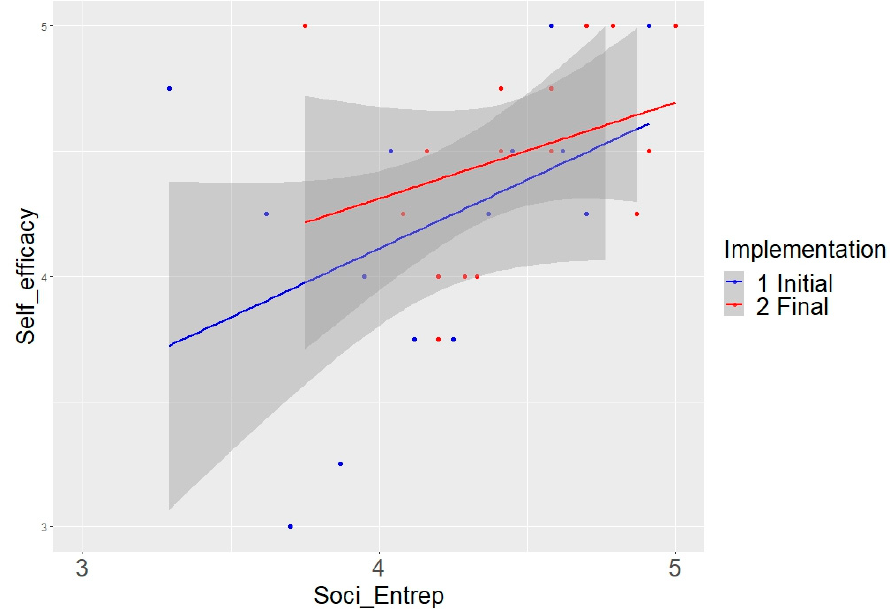
Figure 6. Correlation results of social entrepreneurship and self-efficacy competencies.